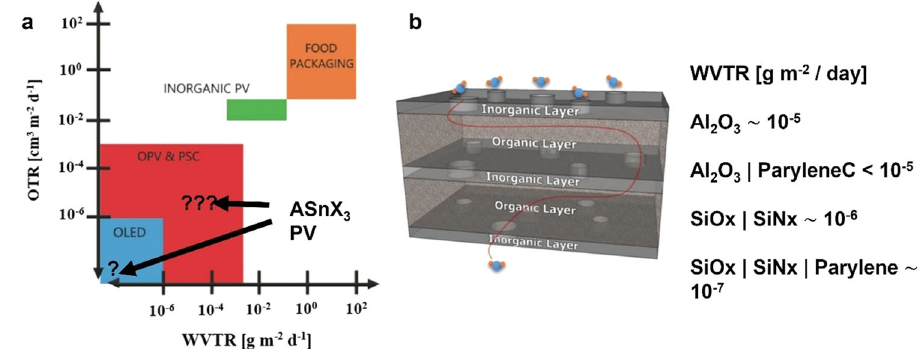
Fig. 8 The OTR and WVTR values required for different applications and the schematic representation of an encapsulating layer. a Oxygen transmission rate and water vapour transmission rate required for different photovoltaic technologies. Food packaging is introduced as a comparison. We note that PSC is considered as lead-based from reference. No estimation is available concerning Sn-HPs PV. b The concept of pinhole decoupling is required in ultra-high barriers, where inorganic and organic thin fi lms are sequentially stacked along with the best values taken from ref. 126 (Fig. 8a adapted with permission from ref. 125 , Copyright 2021 Wiley. Figure 8b reprinted with permission from ref. 137 , Copyright 2018